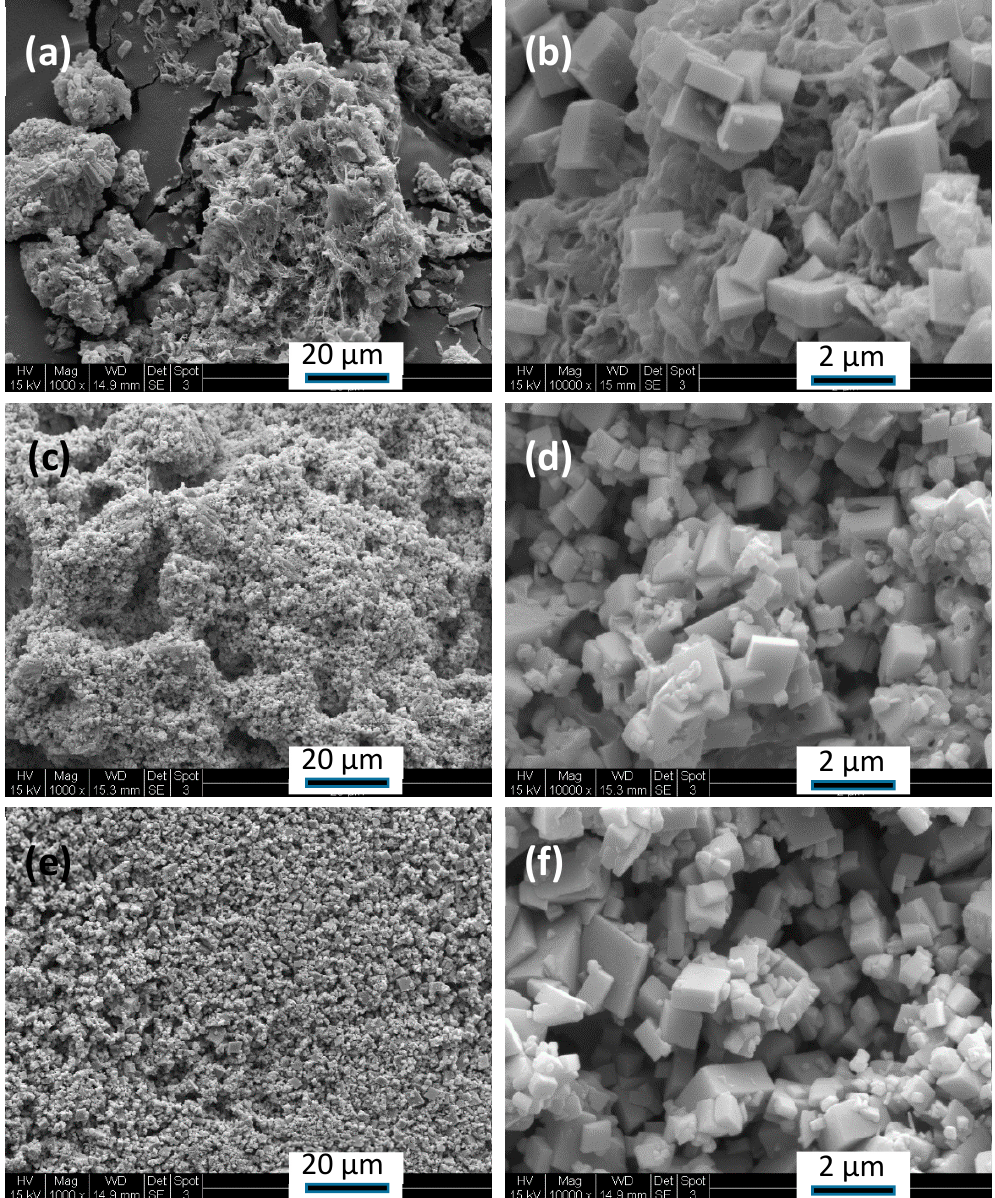
Figure 3. SEM Images after BaSO 4 precipitation; ( a ) and ( b ) PCL/Ba (50/50); ( c ) and ( d ) PCL/Ba (10/90), and ( e ) and ( f ) PCL/Ba (2.5/97.5) composites.